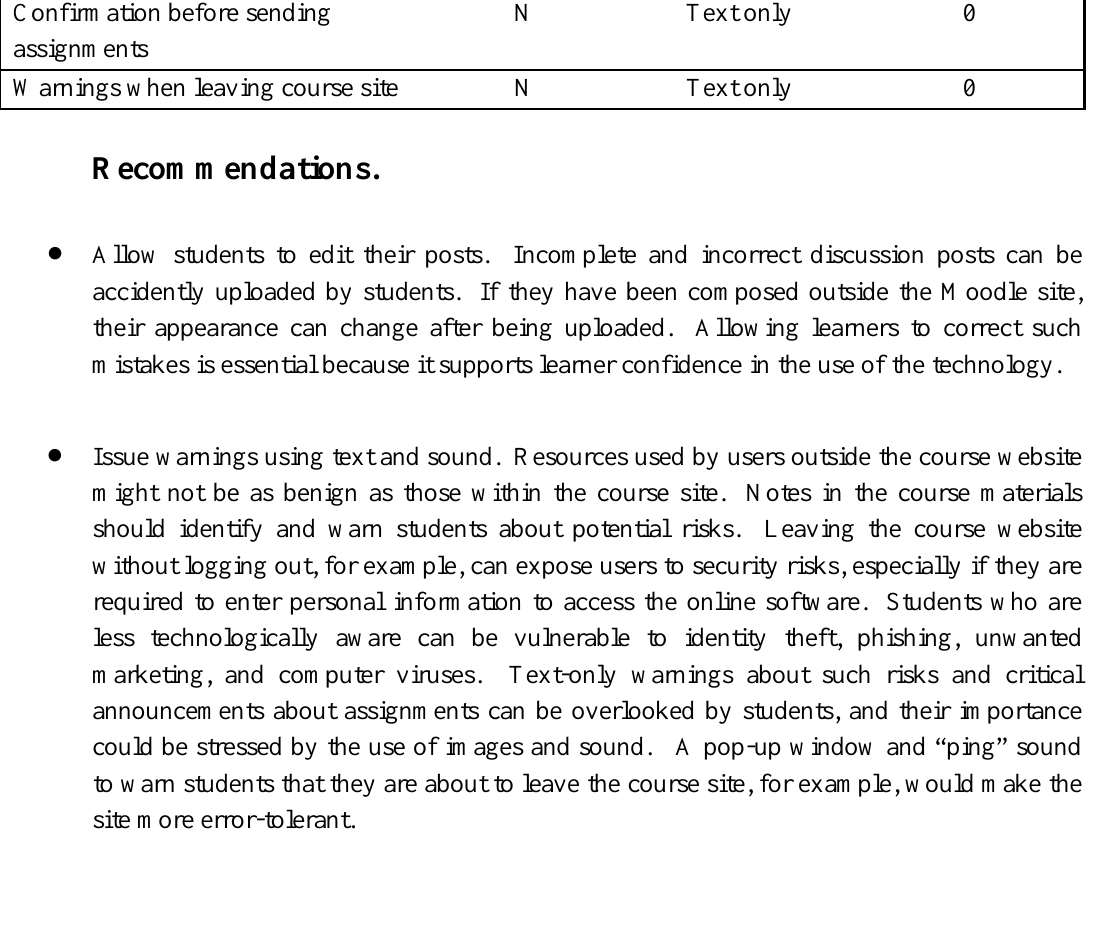
Availability of Moodle Modules Serving the Tolerance for User Error Principle Tolerance for error Available in Ability to edit after posting Y Y Standard feature Confirmation before sending assignments Warnings when leaving course